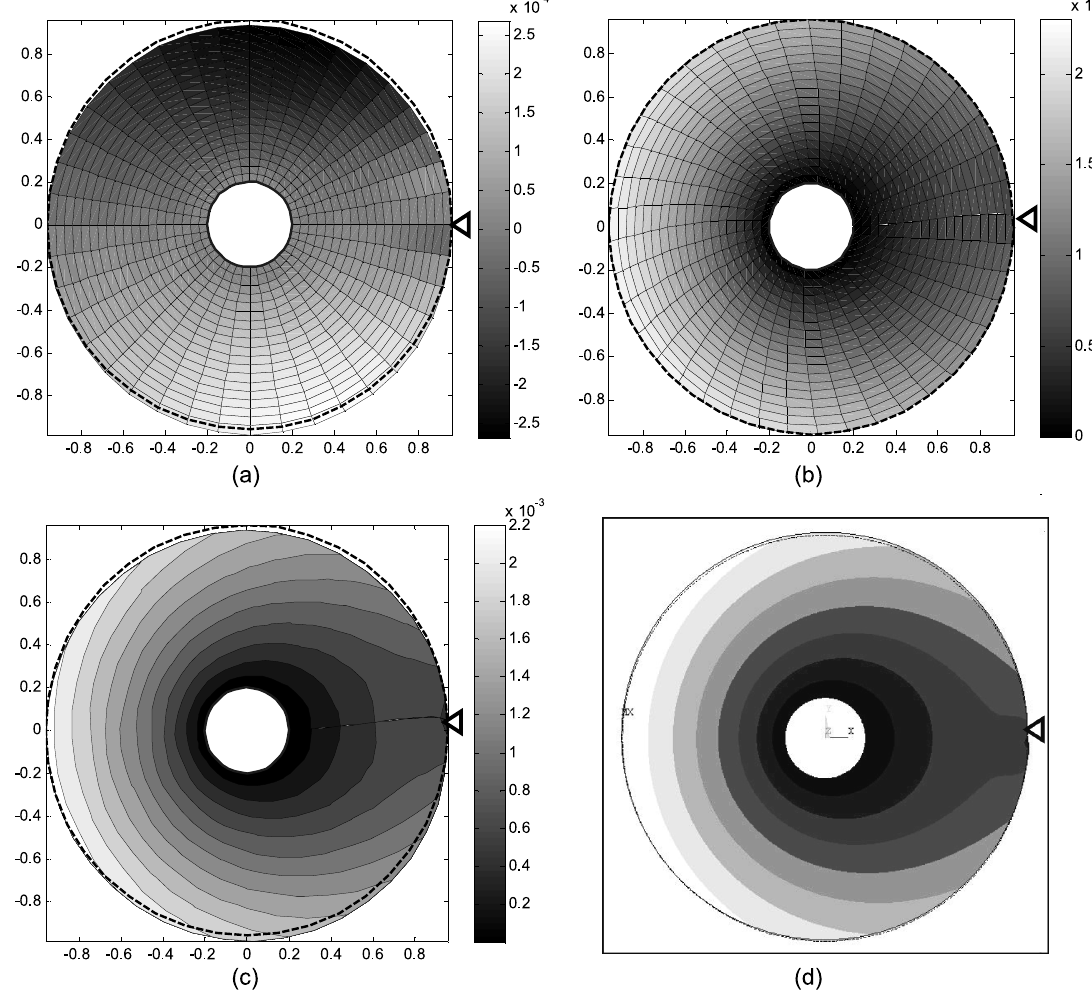
Fig. 6. Contour deformation plots for mode (0,0) for a ’Clamped-Point Clamped’ disk: a) radial displacement; b) circumferential displacement, c) vector sum of displacements; d) deformed shape from Finite element model, : point clamped support , undeformed edge. when the point support stiffness diminishes to free outer edge condition. This tendency was observed for all the four constraint conditions considered. As an additional example, Fig. 4 illustrates the variations in frequency parameters of selected modes of the annular disk with free inner edge but point-supported outer edge with varying support